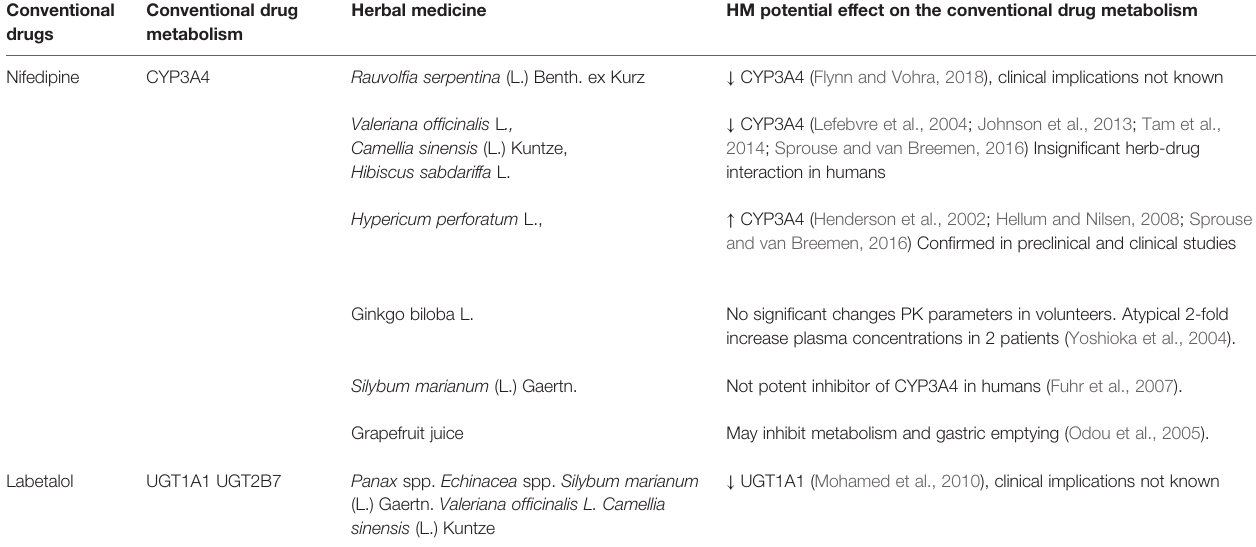
TABLE 3 | Potential HM interactions with conventional antihypertensive drugs taken by pregnant women. Conventional